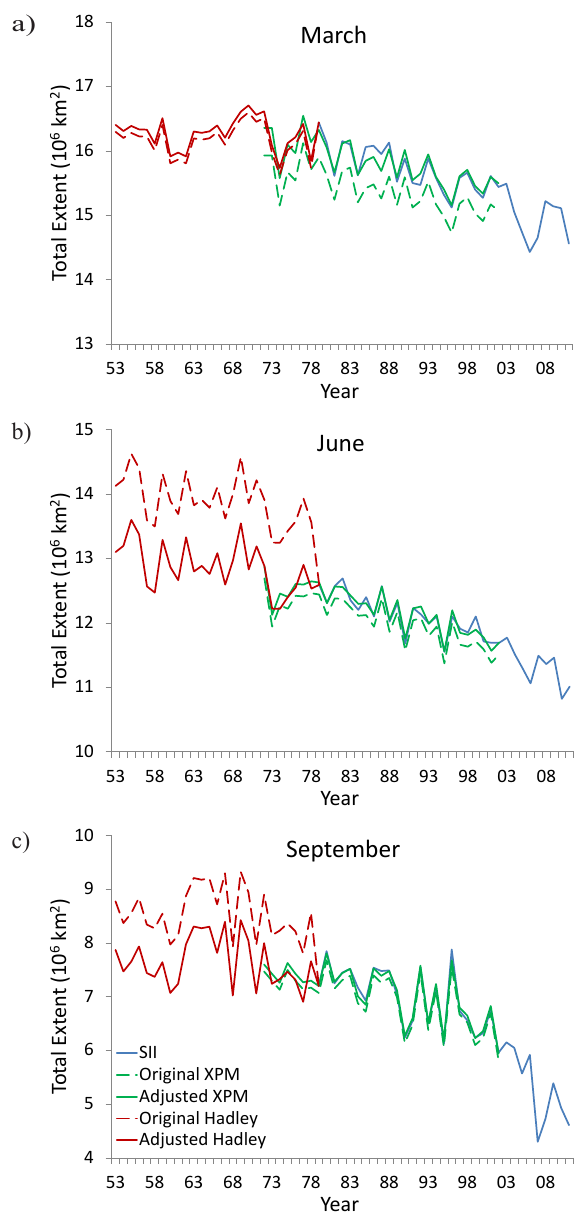
Fig. 1. Sea ice extent for (a) March, (b) June, (c) September for the Sea Ice Index (blue) and original (dashed lines) and adjusted (solid lines) XPM (green) and Hadley (red). March shows good agreement between Hadley and the satellite products and thus little adjustment, but a clear discontinuity between Hadley and SII is apparent in June and